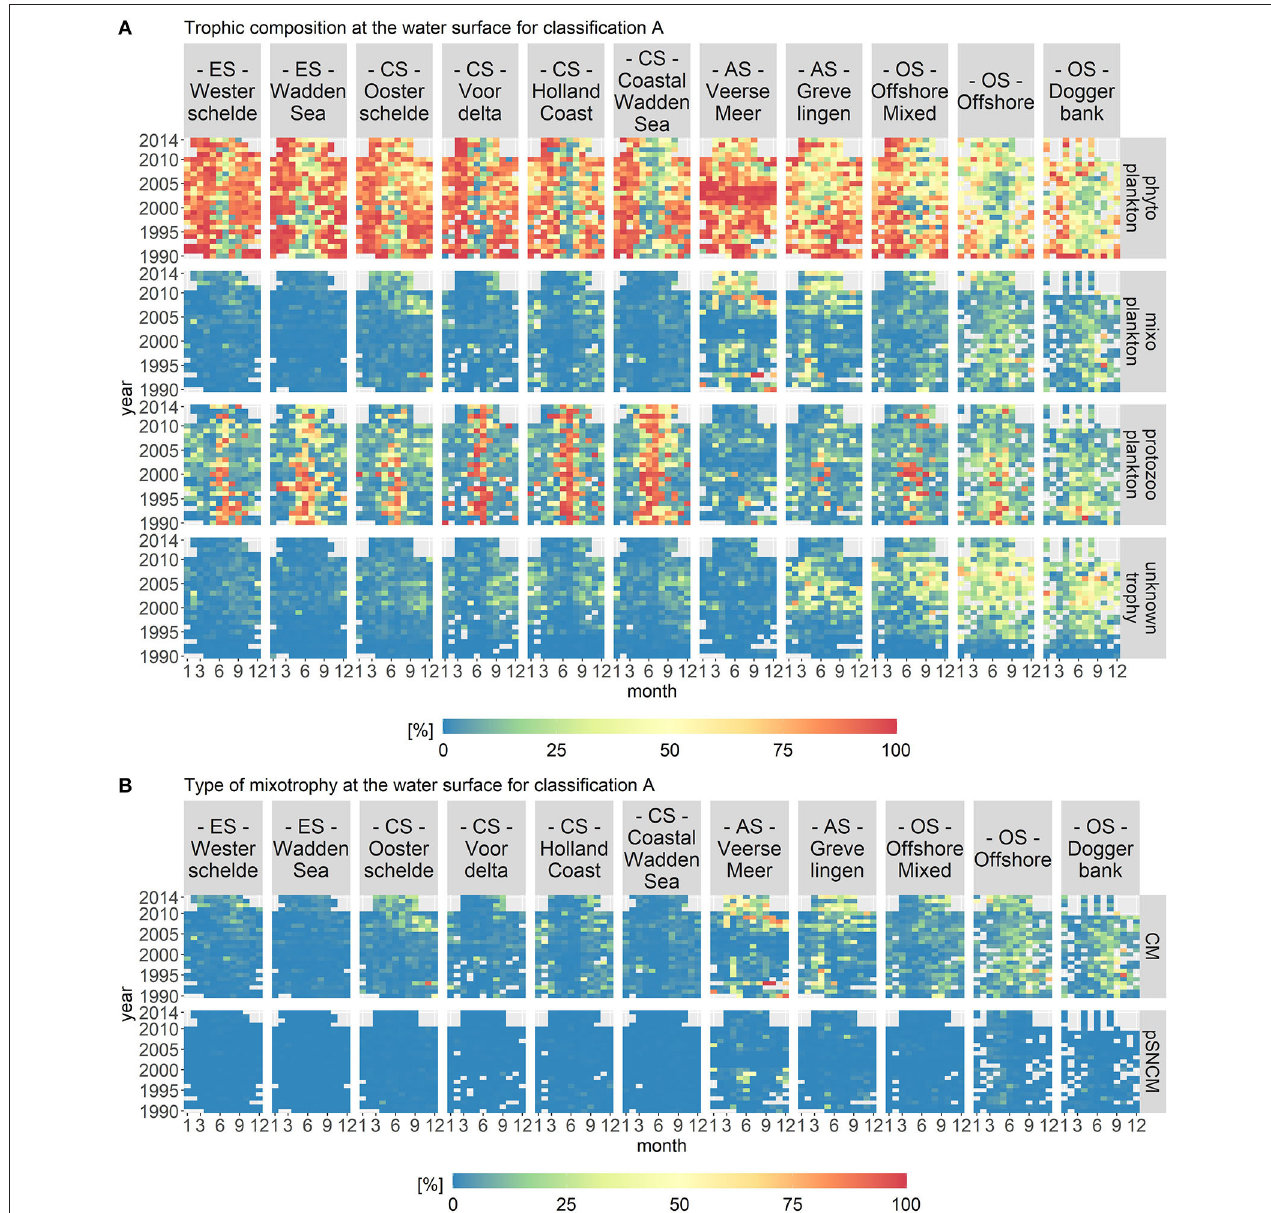
FIGURE 6 | Monthly fractions of the total biomass per trophic mode (A) and per type of mixotrophy (B) for trophic classification A. The location classes are grouped into estuary (ES), coastal (CS), anthropogenically modified (AS), and offshore systems (OS). CM stands for Constitutive Mixoplankton and pSNCM for plastid Specialist Non-Constitutive Mixoplankton, which are a subcategory of NCMs. The occurrence of CMs displays a clear spatial